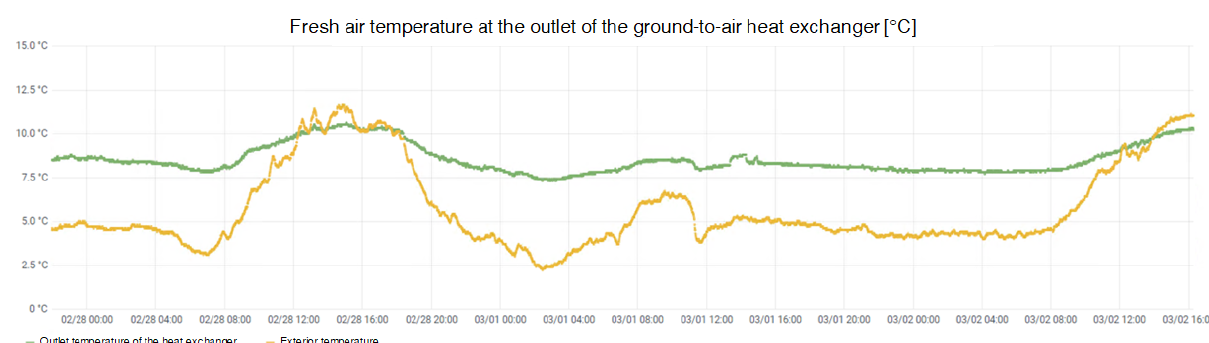
Figure 8. EAHE efficiency.